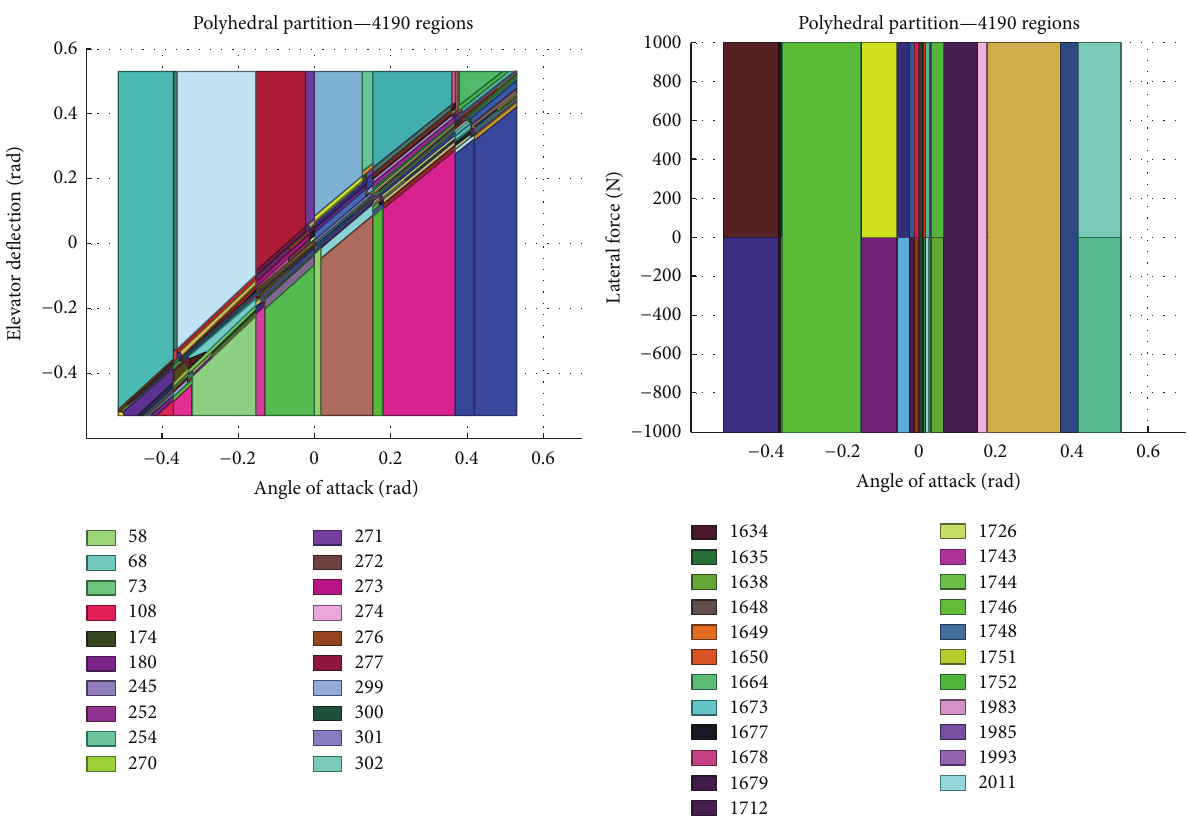
Figure 6: The partition associated with the explicit controller.